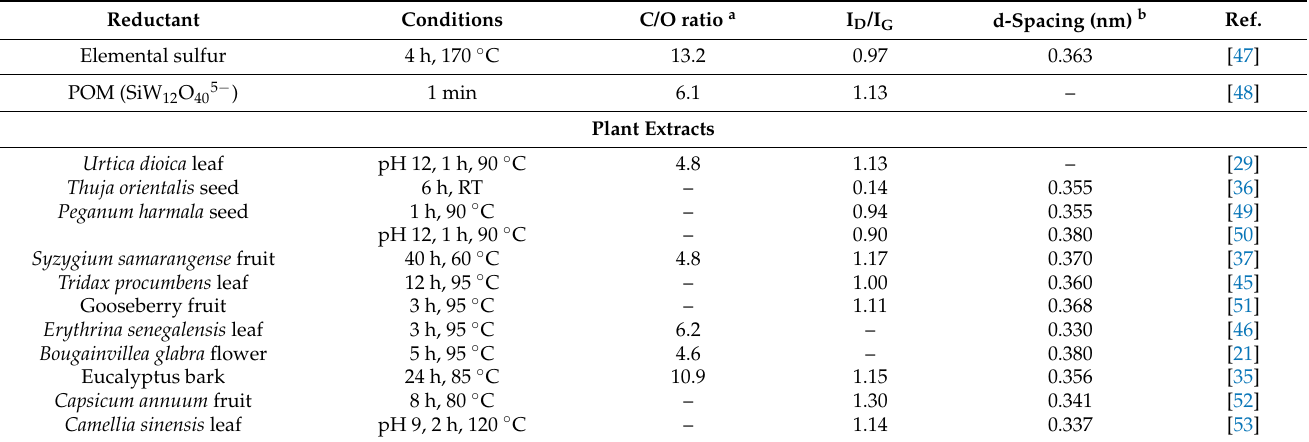
Table 1. Green chemical reducing agents used to convert GO into rGO reported in the last three years.